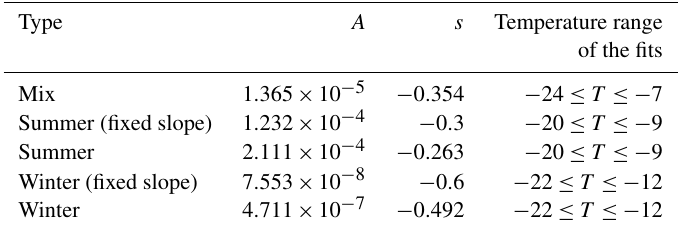
Figure 4. Normalized frequency distributions of N INP at − 12, − 16 and − 20 ◦ C are shown as histograms, together with corresponding log-normal fits. The axis on the right is related to the respective probability density function (PDF). The different colors represent Fletcher (winter) type in blue, Cooper (summer) type in red and mix type in light green, as described in Sect. 3.2. Table 2. Parameters of the INP parameterizations presented in this study. In addition, parameters for fits with a fixed slope are also provided for comparison purpose. The temperature ranges where the fittings were applied are also